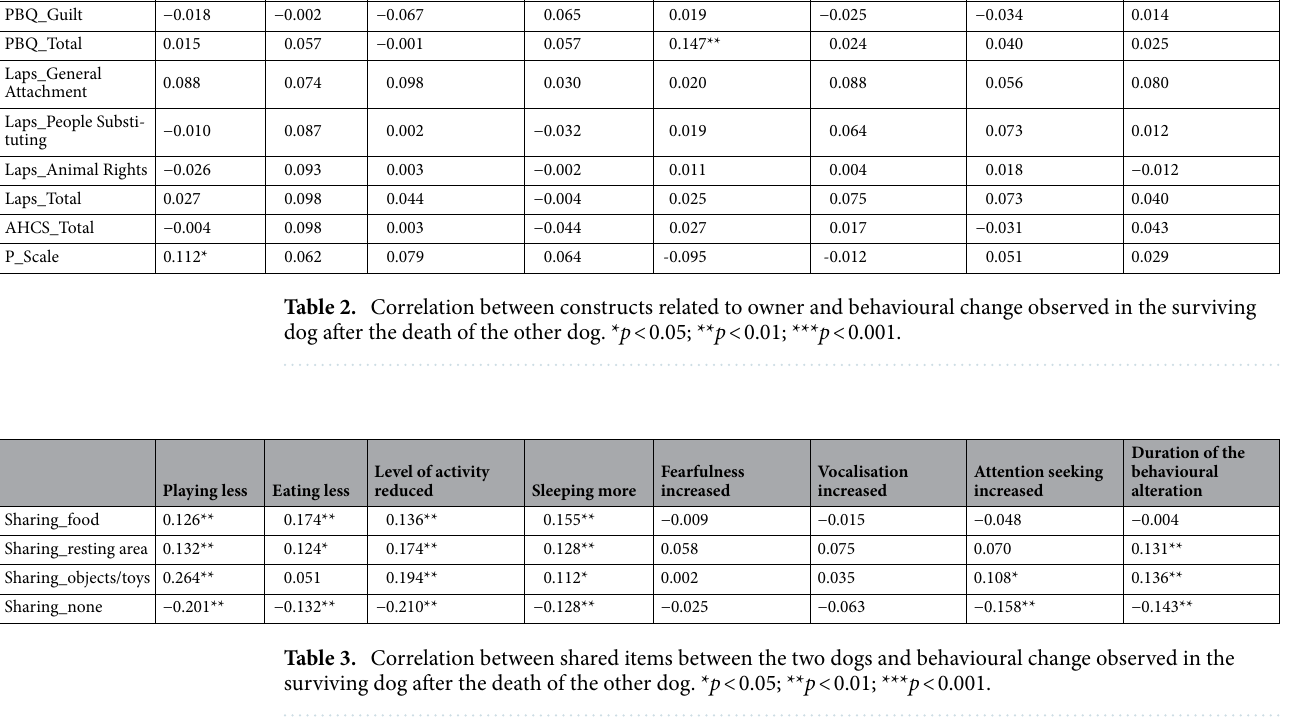
MDQ and behavioural changes. In Table 2, correlations between MDQ parts (PBQ, Laps, AHCS and P-scale scores) and behavioural changes of the surviving dog are reported. “Grief” as assessed by PBQ positively correlated with “eating less” and “fearfulness increased”. “PBQ Anger” and “PBQ Total” positively correlated with “fearfulness increased”. Except for the positive correlation between P scale and playing less, no other cor- relations were revealed between constructs related to the owner and behavioural change in surviving dogs. Shared items and activities between the two dogs and behavioural change. In Table 3, cor- relations between shared items between the two dogs and behavioural change observed in the surviving dog after the death of the other dog are reported. In Table 4, correlations between behavioural changes observed